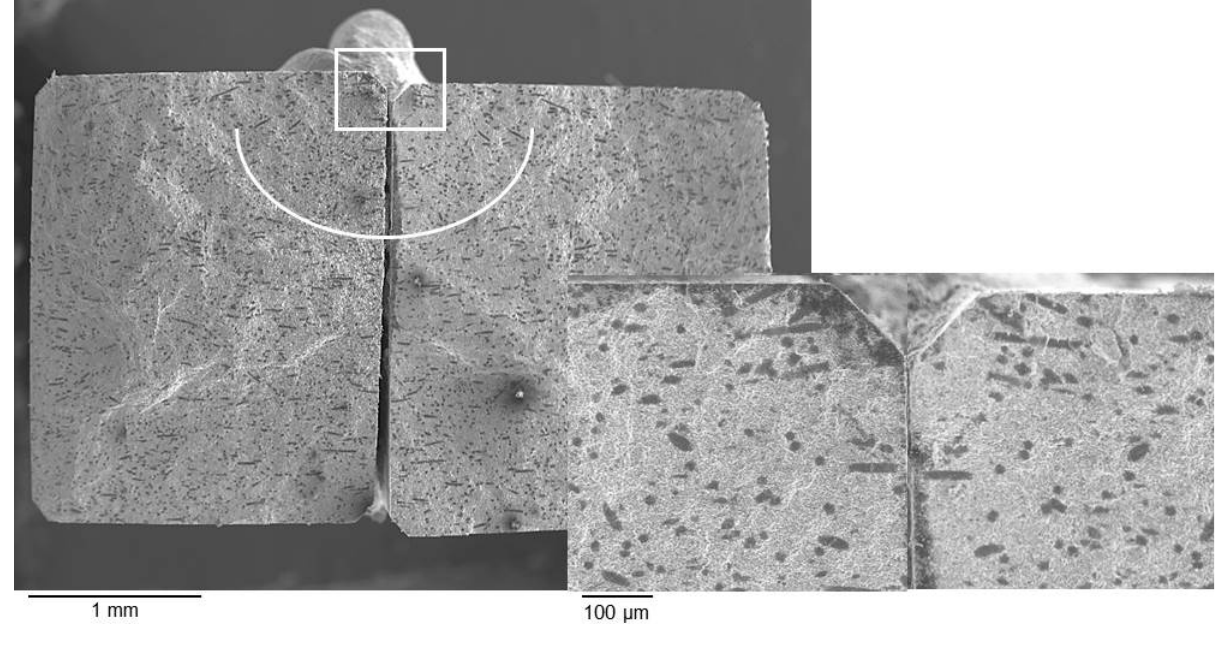
Figure 9. Fracture surface of sample D where the short fibers are aligned perpendicular to the tensile